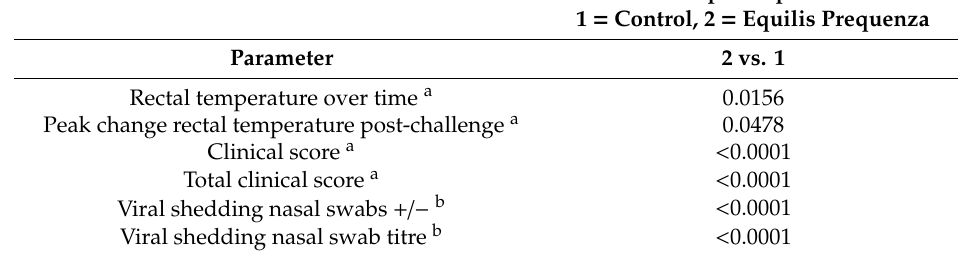
Figure 2. Rectal temperature in groups 1 and 2 after challenge with H3N8 A/equine/Venlo/19 (FC1 sub-lineage). Green square = group 1, Equilis Prequenza vaccinated group; red triangle = group 2, unvaccinated control group. Error bars represent SEM. Inferential statistics: significant difference ( p < 0.05) between groups 1 and 2 (*) (mean effect between 1 and 14 dpc).